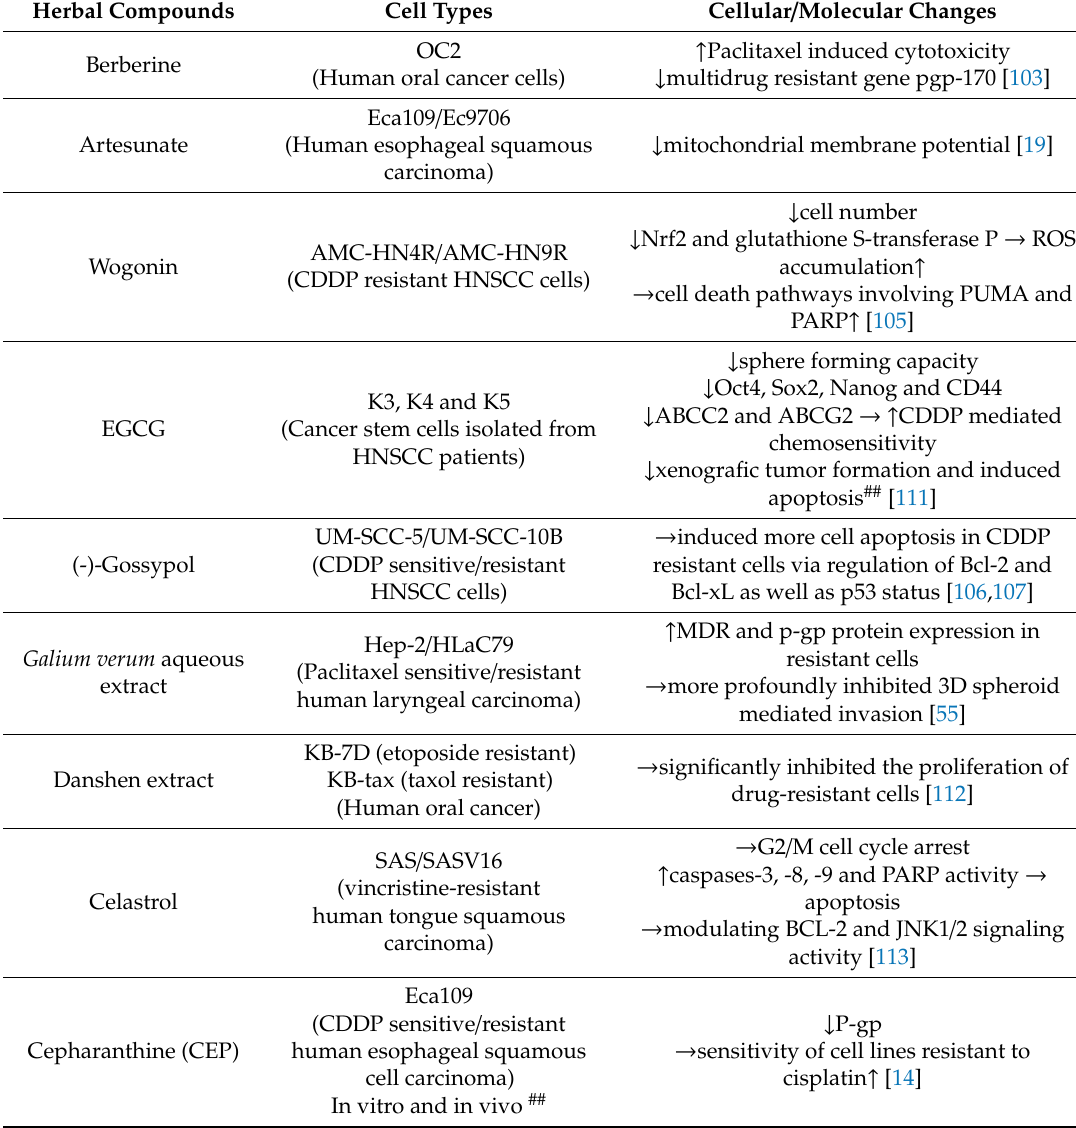
Table 3. Regulatory Impacts of THM compounds for HNSCC Cell Drug